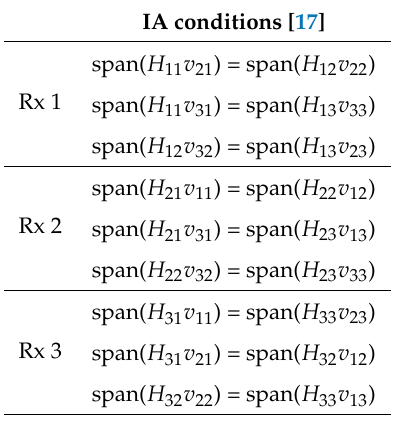
Table A1. K -User MIMO X Interference Alignment (IA) conditions, K =